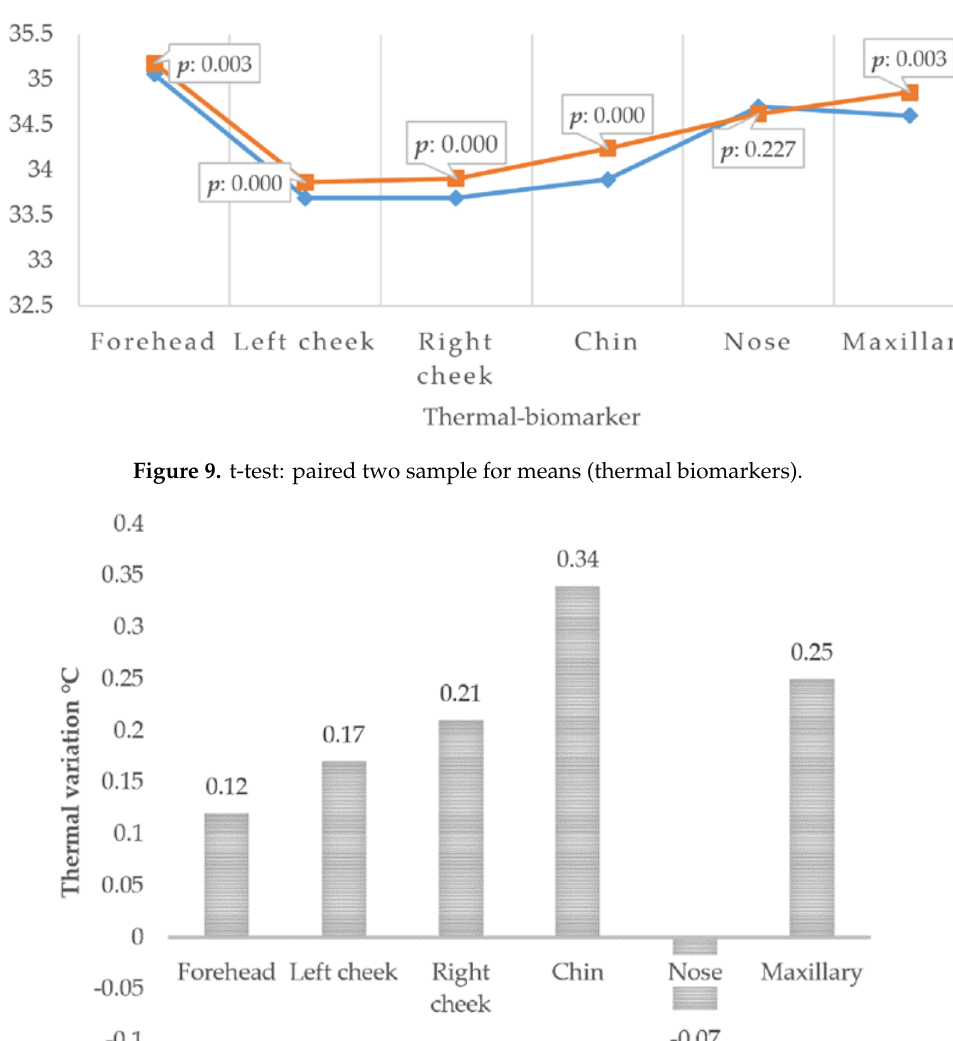
Figure 9. t-test: paired two sample for means (thermal biomarkers).